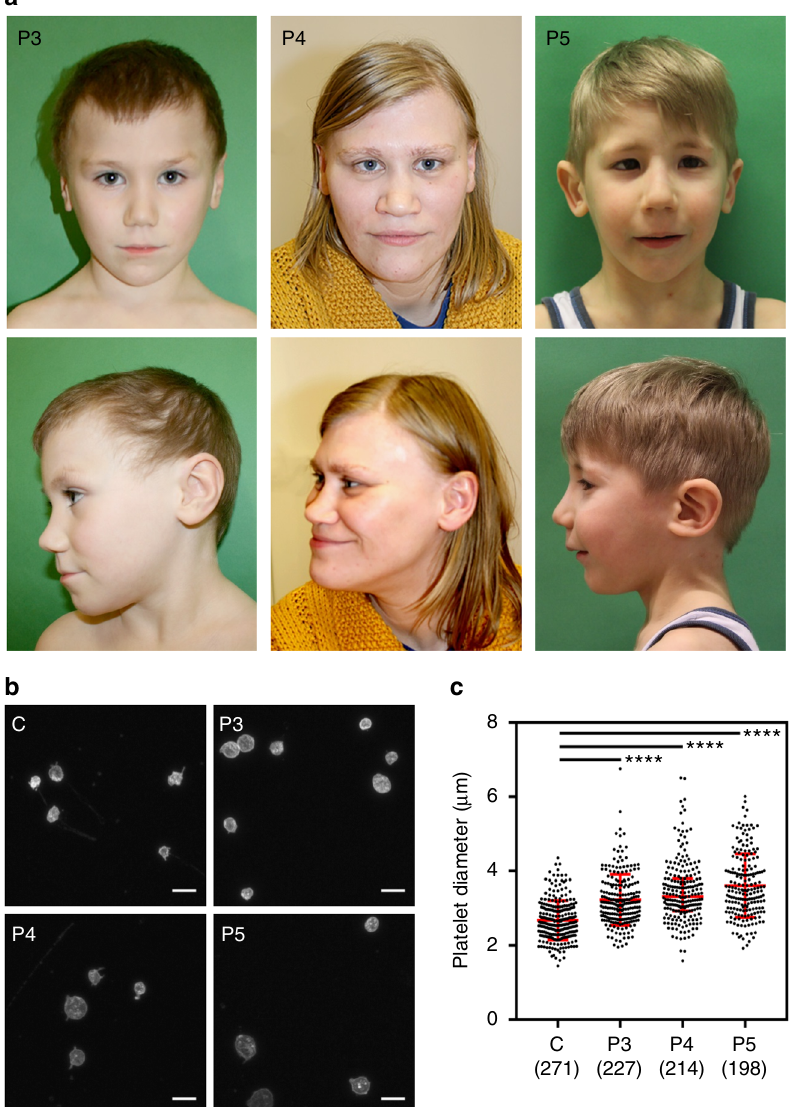
Fig. 2 ACTB -AST patients display minor facial anomalies and thrombocytopenia with enlarged platelets. a Craniofacial appearance of patient 3 (left, P3, p. Ala331Val_fs*27) at 5 years of age, patient 4 (mid, P4, p.Ala331Val_fs*27) at 31 years of age and patient 5 (right, P5, p.Ser338_Ile341del) at 4 year 10 months. Flared eyebrows (P3 and P4), straight eyebrows (P4 and P5), telecanthus (all), epicanthal folds (P3 and P5), upslanting palpebral fi ssures (P3 and P4), a broad nasal tip (P3 and P5), a bulbous nose (P4), a thin upper vermillion border (all) and prominent chin (P4) are observed in these patients; b , c CD61-labeled platelets puri fi ed from a healthy control (C), P3, P4 and P5 were analyzed by immuno fl uorescence microscopy; b Representative images show that platelets in patient samples vary from normal to large in size. Scale bars represent 5 µ m; c Particle analysis shows a signi fi cant shift in the size distribution and average diameter of patient platelets compared with a healthy control. Individual data points are plotted with the median and IQR. The number of platelets analyzed from 1 experiment is given in brackets below each condition. Signi fi cance was determined with the Kruskal – Wallis and Dunn ’ s multiple comparisons tests, where **** p <